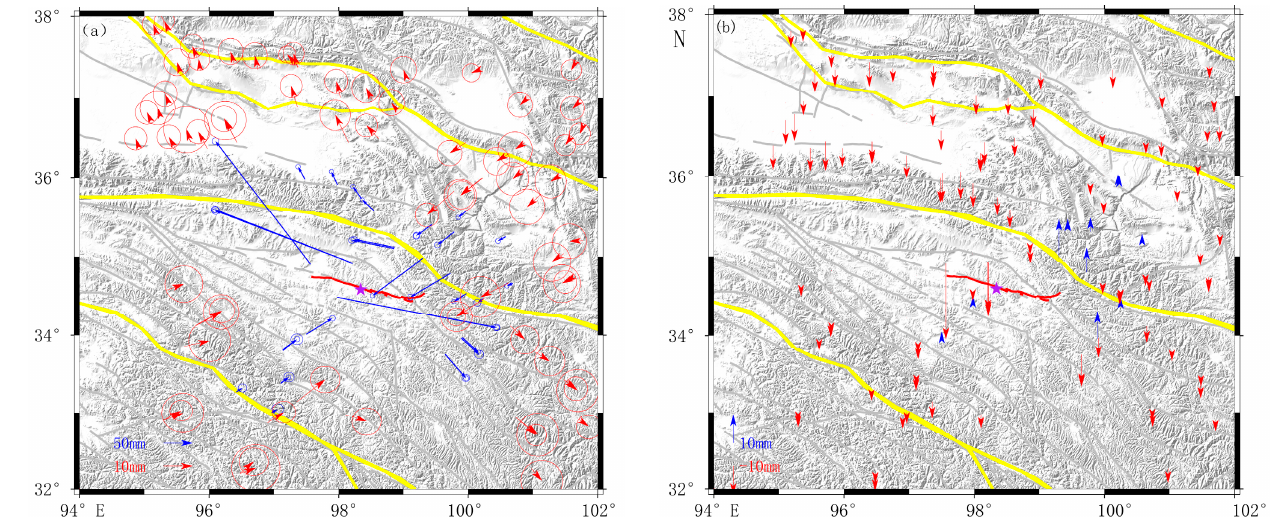
Figure 2. The co-seismic displacement obtained by GNSS data. The yellow lines are the secondary tectonic block boundary, ( a ) represents the co-seismic displacement in horizontal direction, the blue and the red arrows represent the different displacement ratio, and ( b ) represents the co-seismic displacement in the vertical direction. The blue represents the uplift displacement, and the red represents the subsidence displacement: the red circle represents the error ellipse, the purple star represents the epicenter of the Maduo M S 7.4 earthquake, the red curve near the epicenter represents